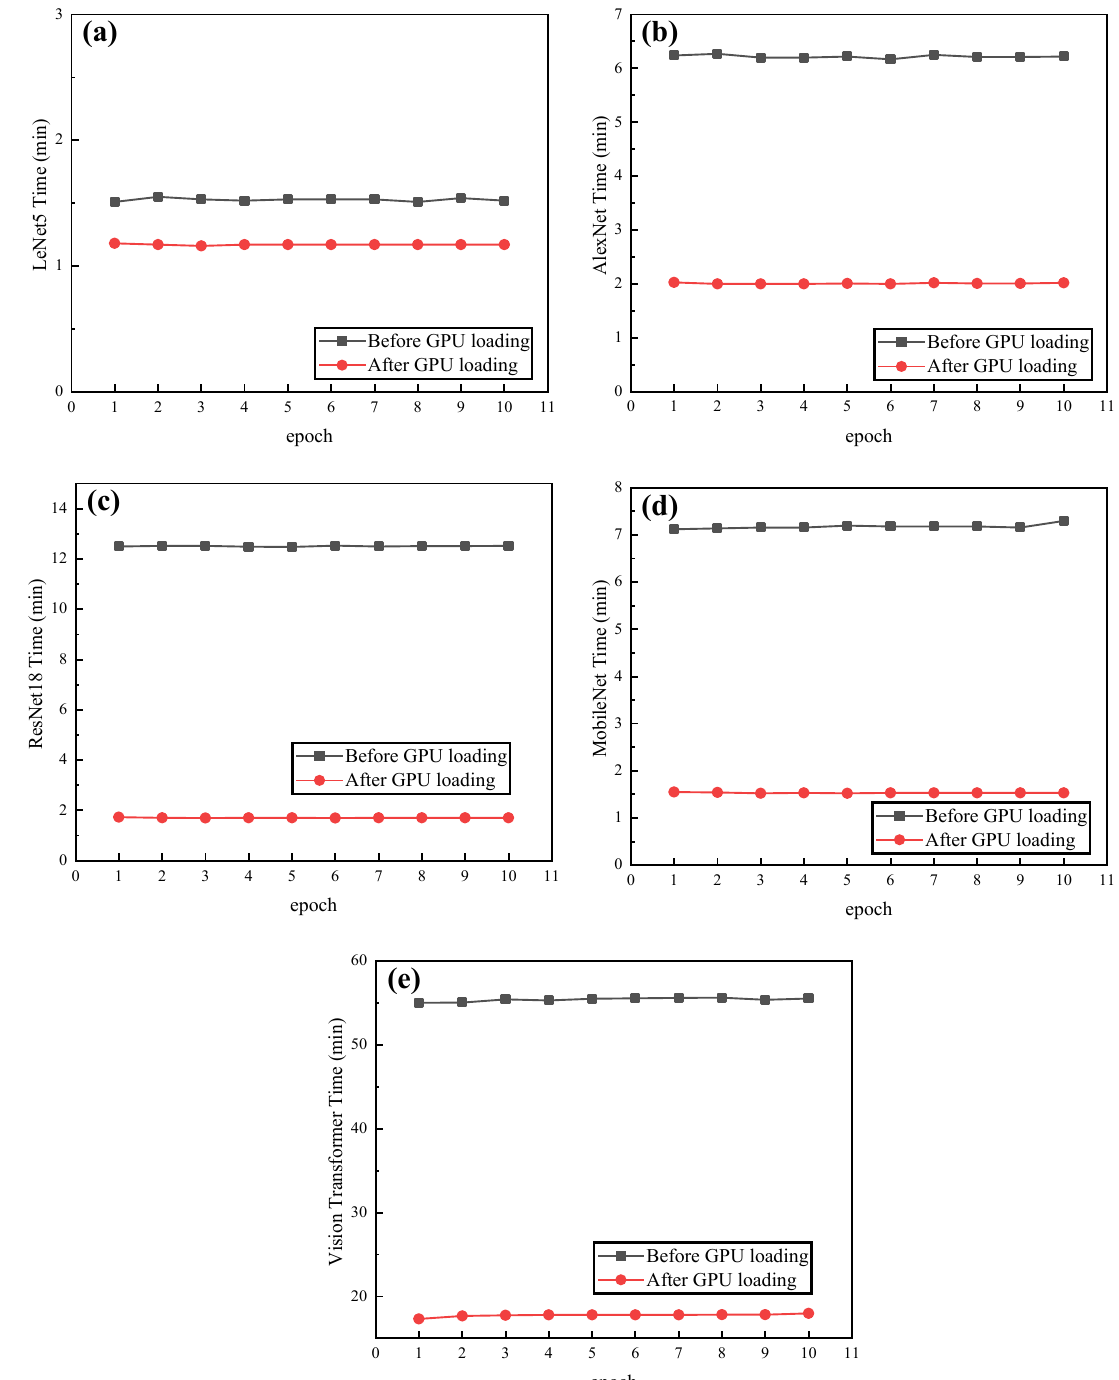
Figure 7. Comparison of the efficiency of each model before data augmentation before and after GPU loading . ( a ) Comparison of the efficiency of LeNet5 model. ( b ) Comparison of the efficiency of AlexNet model. ( c ) Comparison of the efficiency of ResNet18 model. ( d ) Comparison of the efficiency of MobileNet model. ( e ) Comparison of the efficiency of Vision Transformer